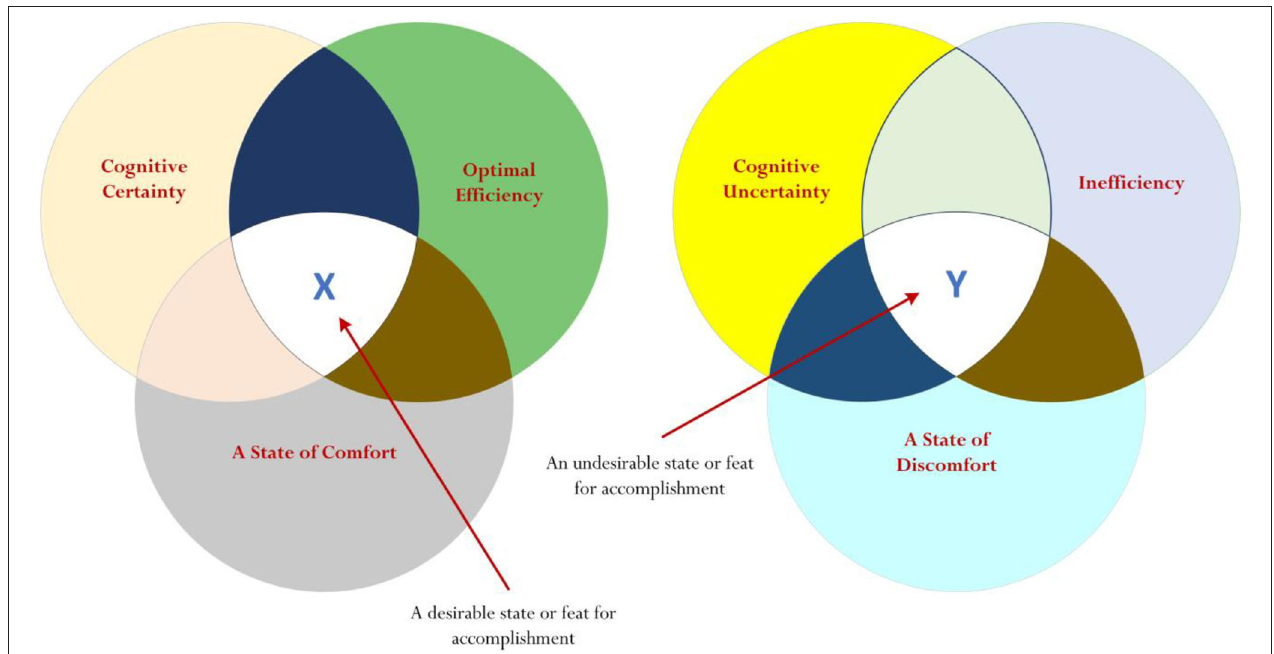
FIGURE 3 | Proposition for consideration: cognitive certainty, optimal efficiency, and state of